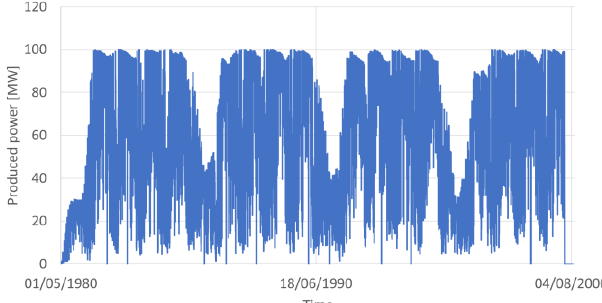
Fig. 24. Time series of produced power over the life of the farm with c/d time=1 hr, in the case of scenario B (onshore teams=2,